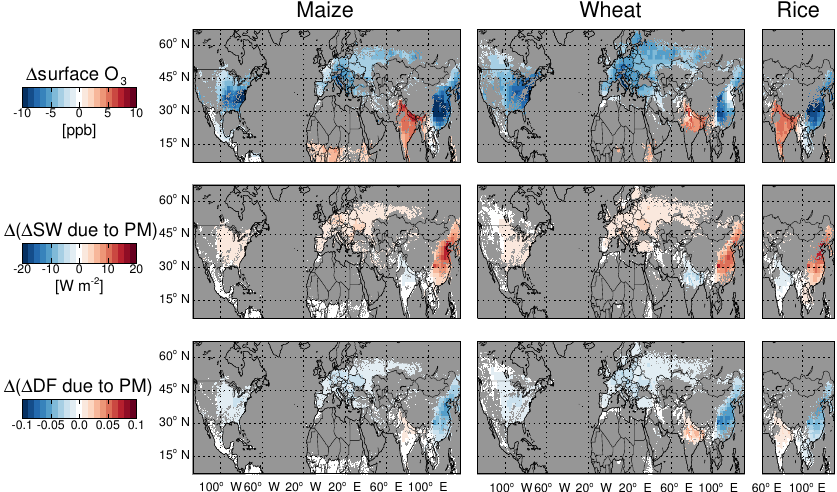
Figure 9. Same as Fig. 5, but for change in quantities using RCP4.5 emissions scenarios (2050 − 2010).